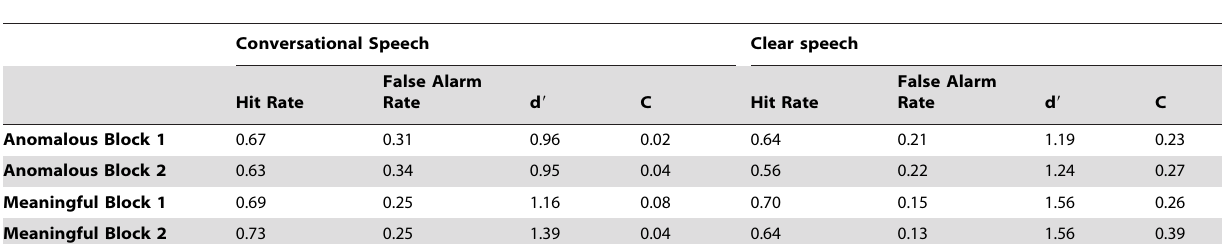
Table 5. Calculated hit rates, false alarm rates, d 9 , and C values for the recognition memory